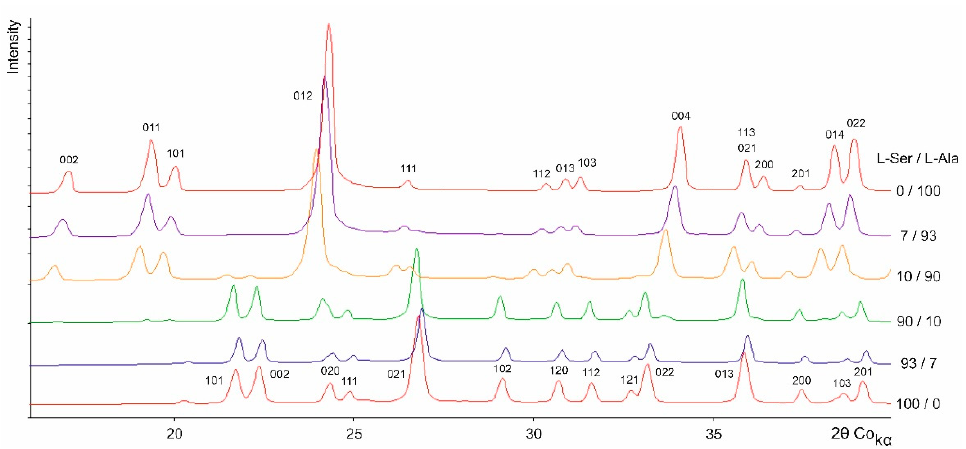
Figure 4. X-ray patterns (2 θ Co K α ) of the co-precipitated mixtures (mol. %): L-ser/L-ala = 0/100, 7/93, 10/90, 90/10, 93/7, and 100/0. Table 1. Parameters and volume of the orthorhombic cell for L-ser, L-ala, and their solid solutions with L-ser/L-ala ratios of 7/93 and 93/7.